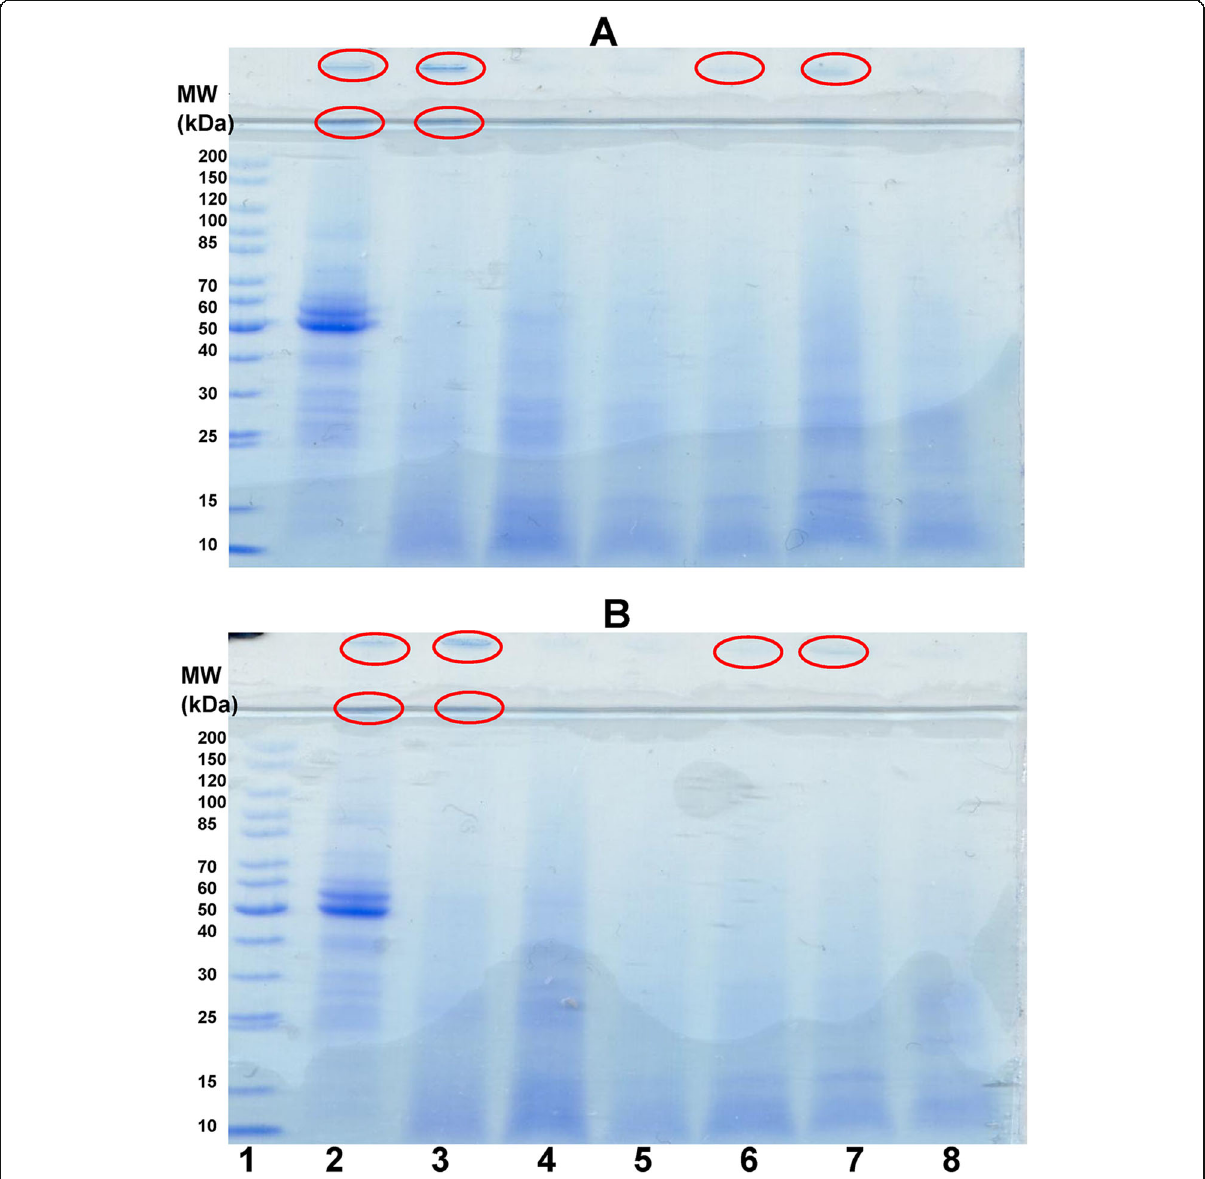
Fig. 4 Non-reducing SDS-PAGE of cowpea protein isolate (CPI), indigestible proteins (ICP) obtained after pepsin + pancreatin digestion of CPI pretreated with gelation (slow cooling), and 6th week feces from a male and b female rats: lane 1, standard molecular weight markers; lane 2, CPI; lane 3, ICP; lane 4, feces at baseline (before feeding experiment); lane 5, 20% of casein; lane 6, 19% of casein + 1% ICP; lane 7, 15% casein + 5% ICP; lane 8, 15% casein + 5% CPI. The high molecular weight bands are